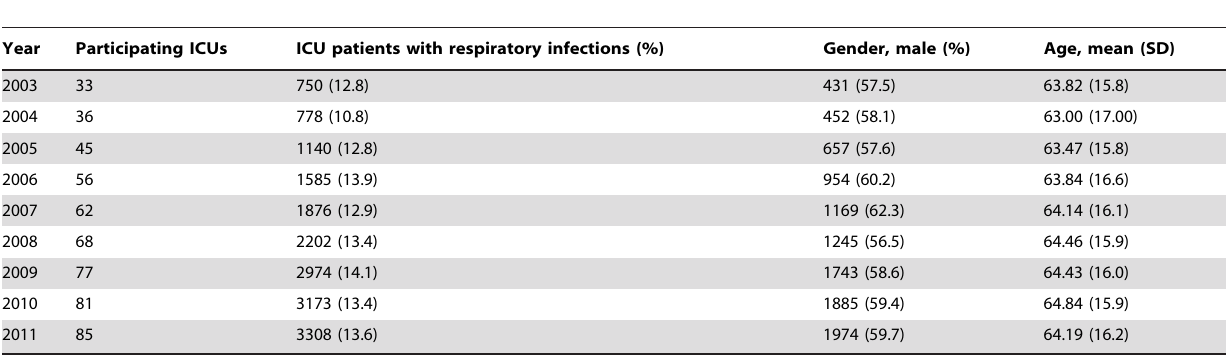
Table 1. Number of participating Intensive Care Units (ICUs), number and percentage of medical ICU admissions for respiratory infections and gender and age distribution.